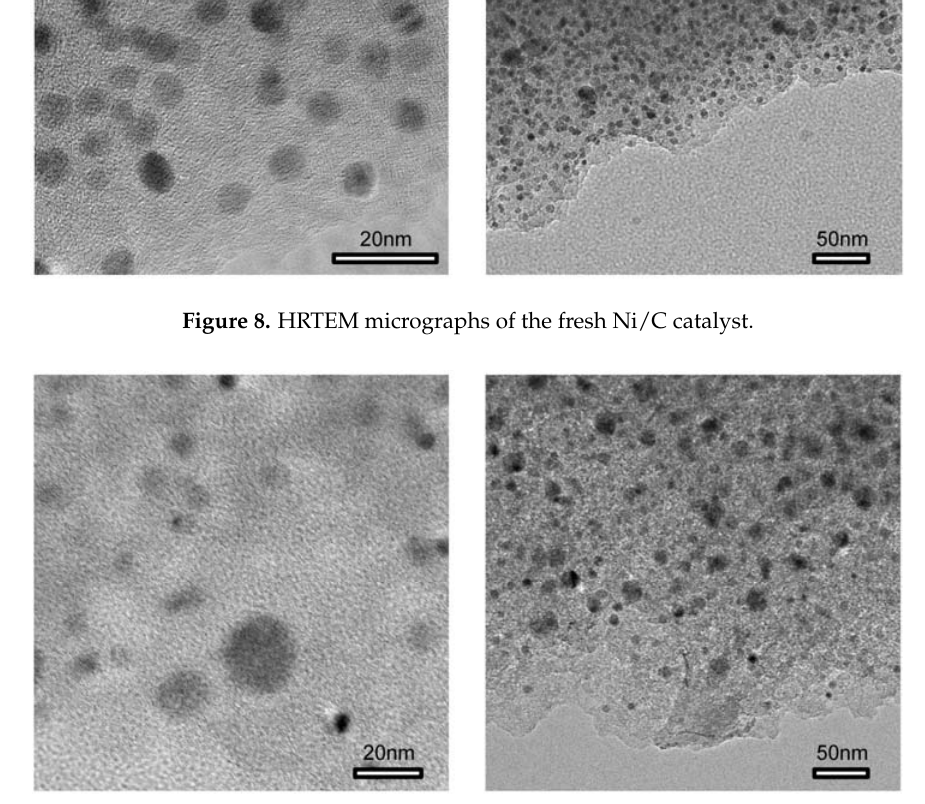
Figure 9. HRTEM micrographs of Ni/C catalyst after six times reaction.